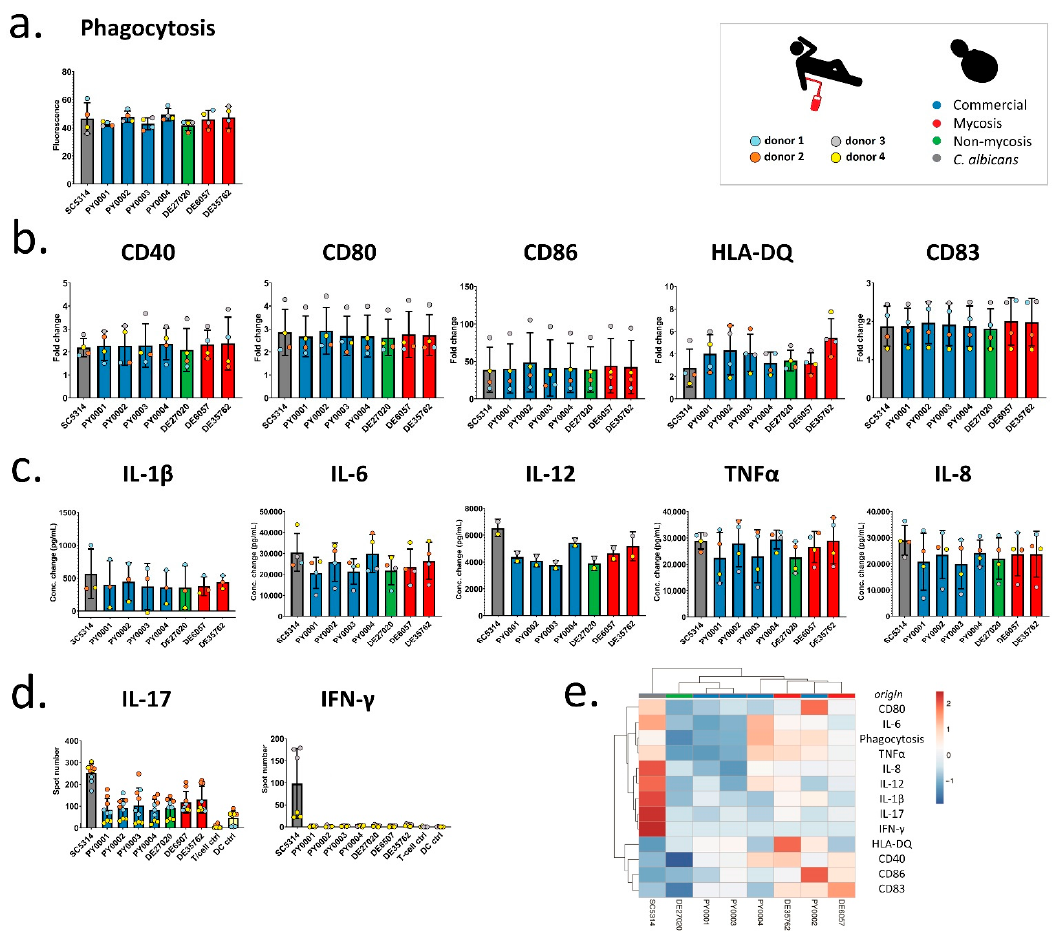
Figure 4. Immunological interactions. ( a ) Phagocytic activity of moDC for the various yeasts. Phagocytic activity of moDCs (fluorescence) corrected with uninfected and 4 °C controls shown for each donor. ( b ) Fold changes in measured moDC markers. Fold changes in fluorescence are depicted for moDC markers, except for CD83, where fold change in the percentage of positive cells is shown instead. ( c ) Cytokine/chemokine production. Change in concentration (pg/mL) shown for each measured cytokine/chemokine secretion. ( d ) T-cell activation by activated moDCs. Number of recorded spots in ELISPOT assay are shown. Photographs of ELISPOT assays are depicted in Supplementary File S7. ( a – d ): Bars represent mean values, whiskers show standard deviation. Individual data points are colored according to donor, bars are colored according to yeast group as shown in inset. ( e ) Phenotypic clustering of isolates based on immunological interactions. Unit variance scaling is applied to rows. Rows are clustered using correlation distance and average linkage. Columns are clustered using Euclidean distance and average linkage. Donor means were used for clustering.